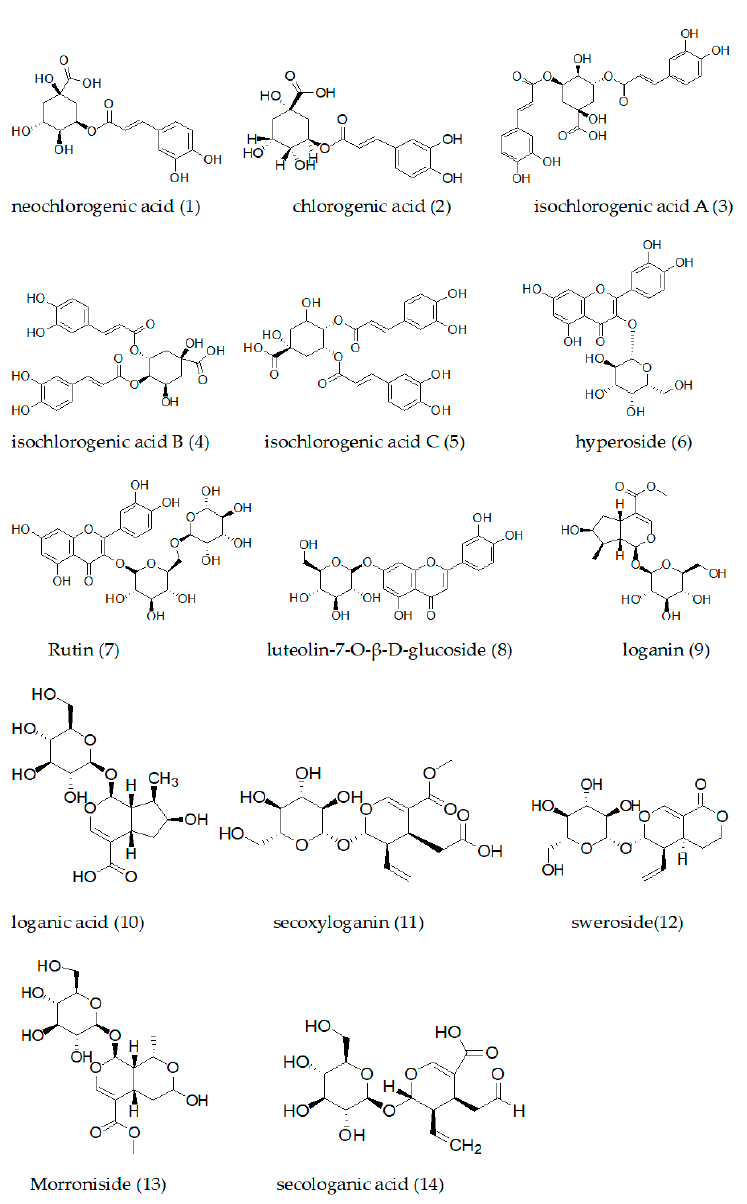
Figure 1. Chemical structures of the representative components in flower buds of Lonicerae species (1 – 14).